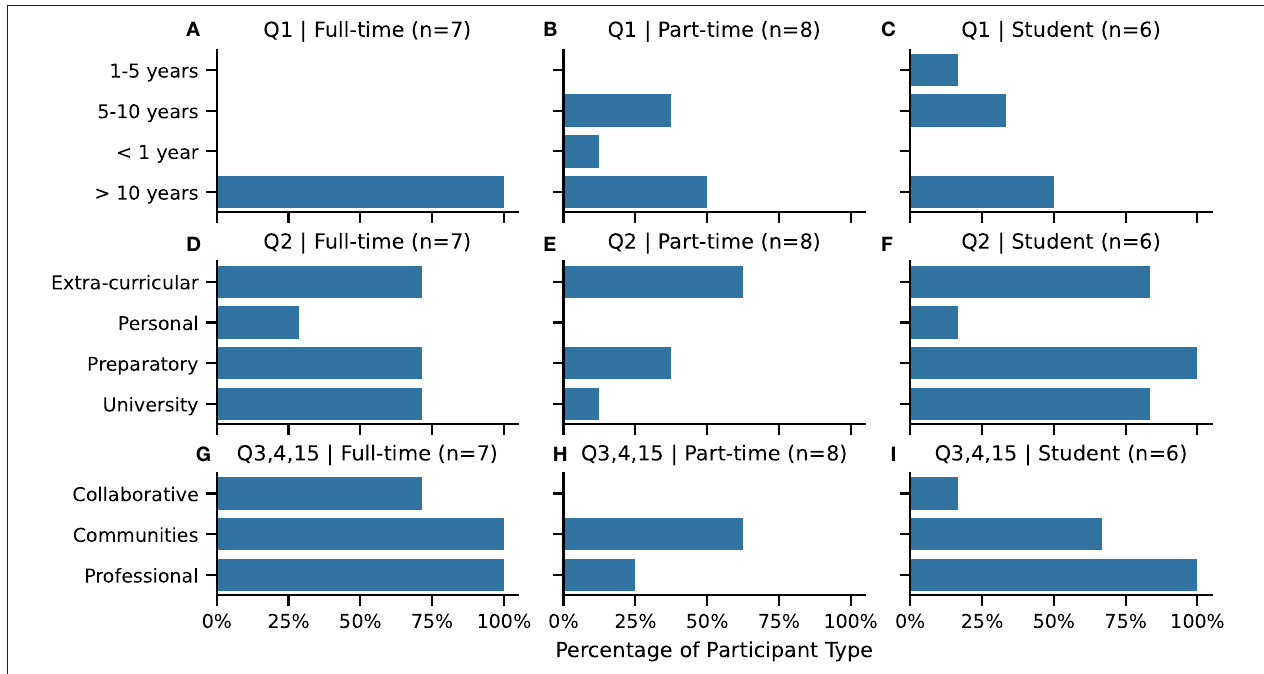
FIGURE 2 | (A–C) Q1. Self-reported years spent drawing. (D–F) Q2. Drawing education. (G–I) Drawing practise: participation in collaborative or collective drawing (Q3), in drawing communities (Q4) or as a professional drawer (Q15). Abbreviations are in bold . Participants selected all answers that apply, except for Q1 where participants selected only one